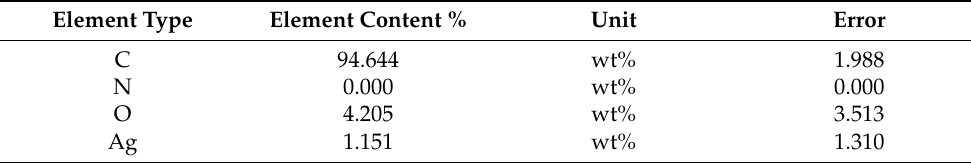
Figure 7. SEM and EDS of AgNPs-PS side in the composite membrane: ( a ) SEM image of AgNPs-PS nanofiber with the chosen position; ( b ) EDS image of AgNPs-PS nanofiber. Table 2. Content of various elements in AgNPs-PS nanofiber membrane. Element Type